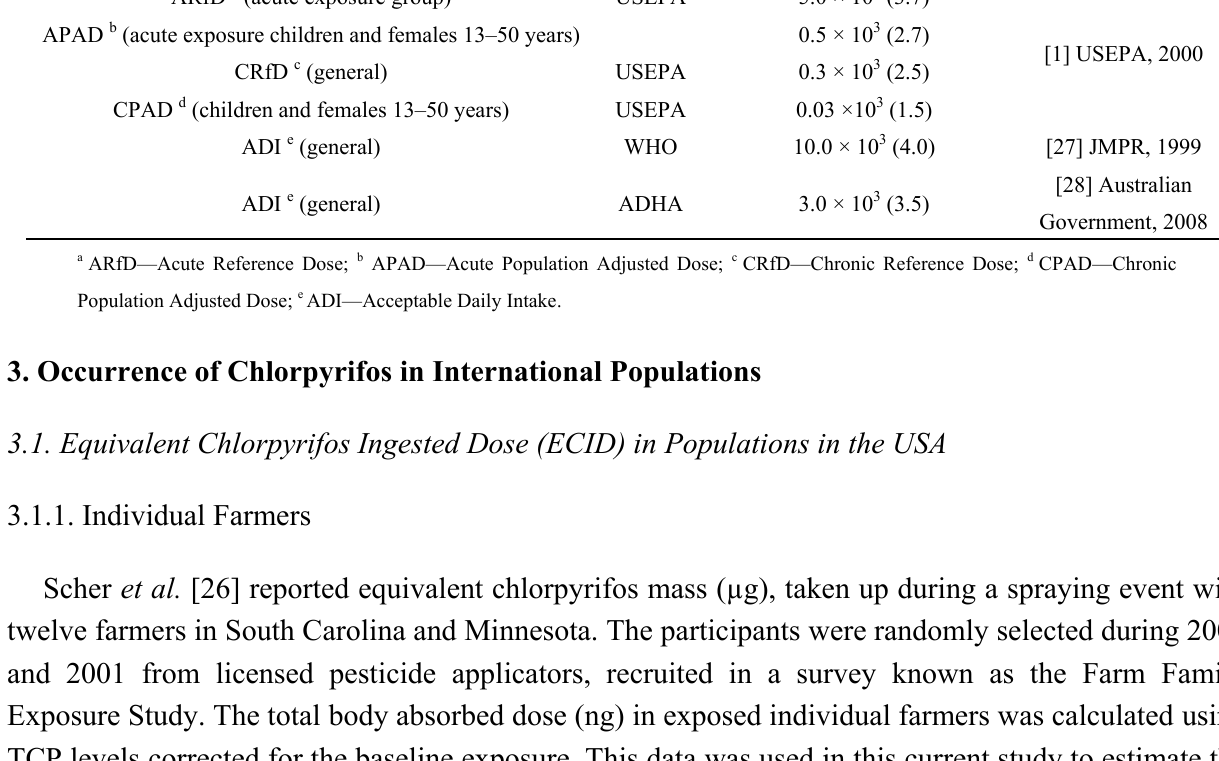
Table 1. Examples of guideline values (GV) developed by various agencies. Guideline description (applicable population